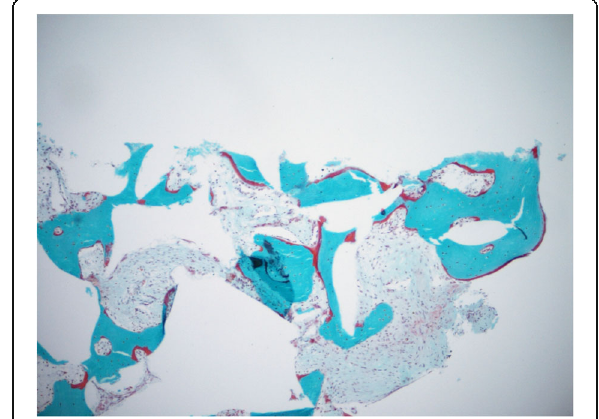
Fig. 6 Patient # 1 (12-month healing time): increased bone formation following the shape of the grafted particles that are still present (magnification